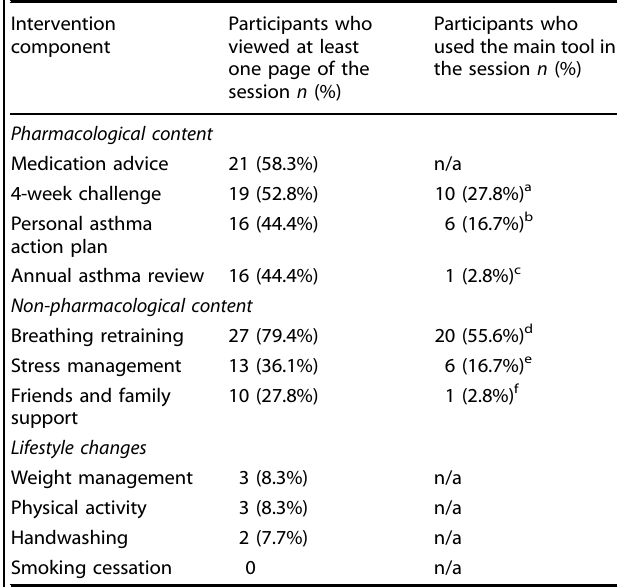
Table 2. Numbers (and percentages) of participants who used each intervention component ( n =